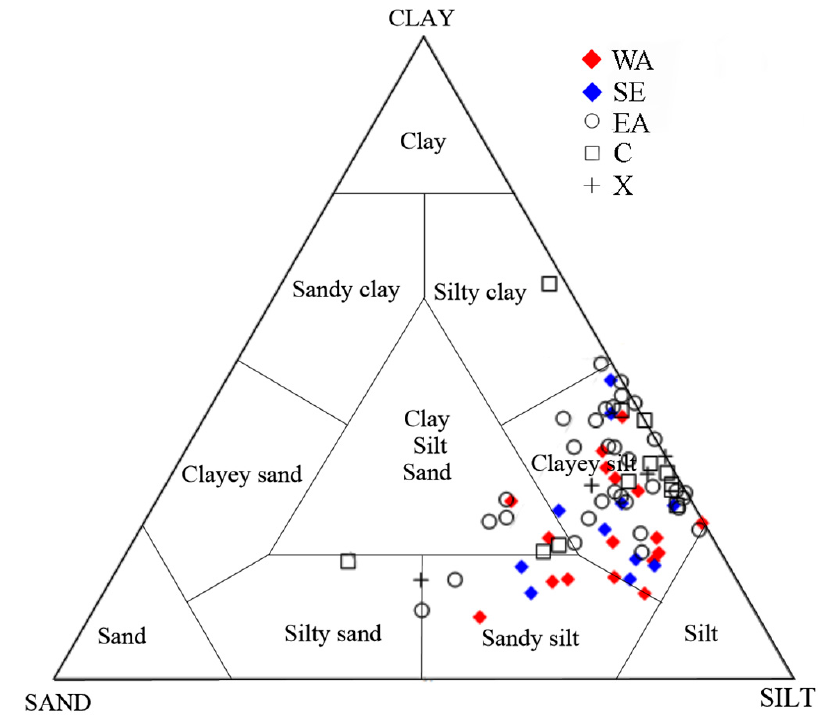
Figure 4. Classification of the studied samples vs. eastern Achaean, Corinthian, and Xylokastro clay-rich sediments according to their grain size distribution and their projection on the Shepard diagram [26]. The data for Eastern Achaean, Corinthia, and Xyloakastro are given elsewhere [12]. In the plot of all the studied samples, on Casagrande’s chart, the samples WA23, AM2, and PL2 are characterized as silts of high plasticity, whereas AM2 and PL2 are clays of high plasticity (Figure 5). The presence and high percentage of smectite in the two last samples is correlated with the high plasticity index. Four samples (N1, N2, N3, and WA5) are plotted on the field of clays of low plasticity and one on silts of low plasticity. In relation to the samples from eastern Achaea and Corinth, the samples from western Achaea have LL and PI, whereas the majority of the samples from south Epirus have a higher plasticity index (Table